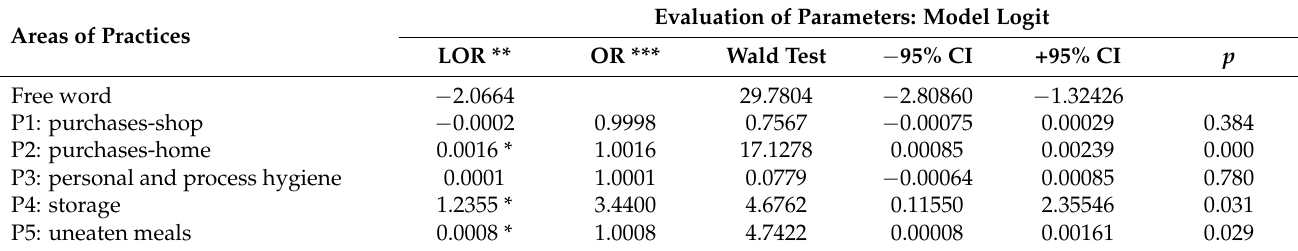
Table 8. The results of analysis with the use of the logit model showing relations between chosen models of dealing with food and waste due to its